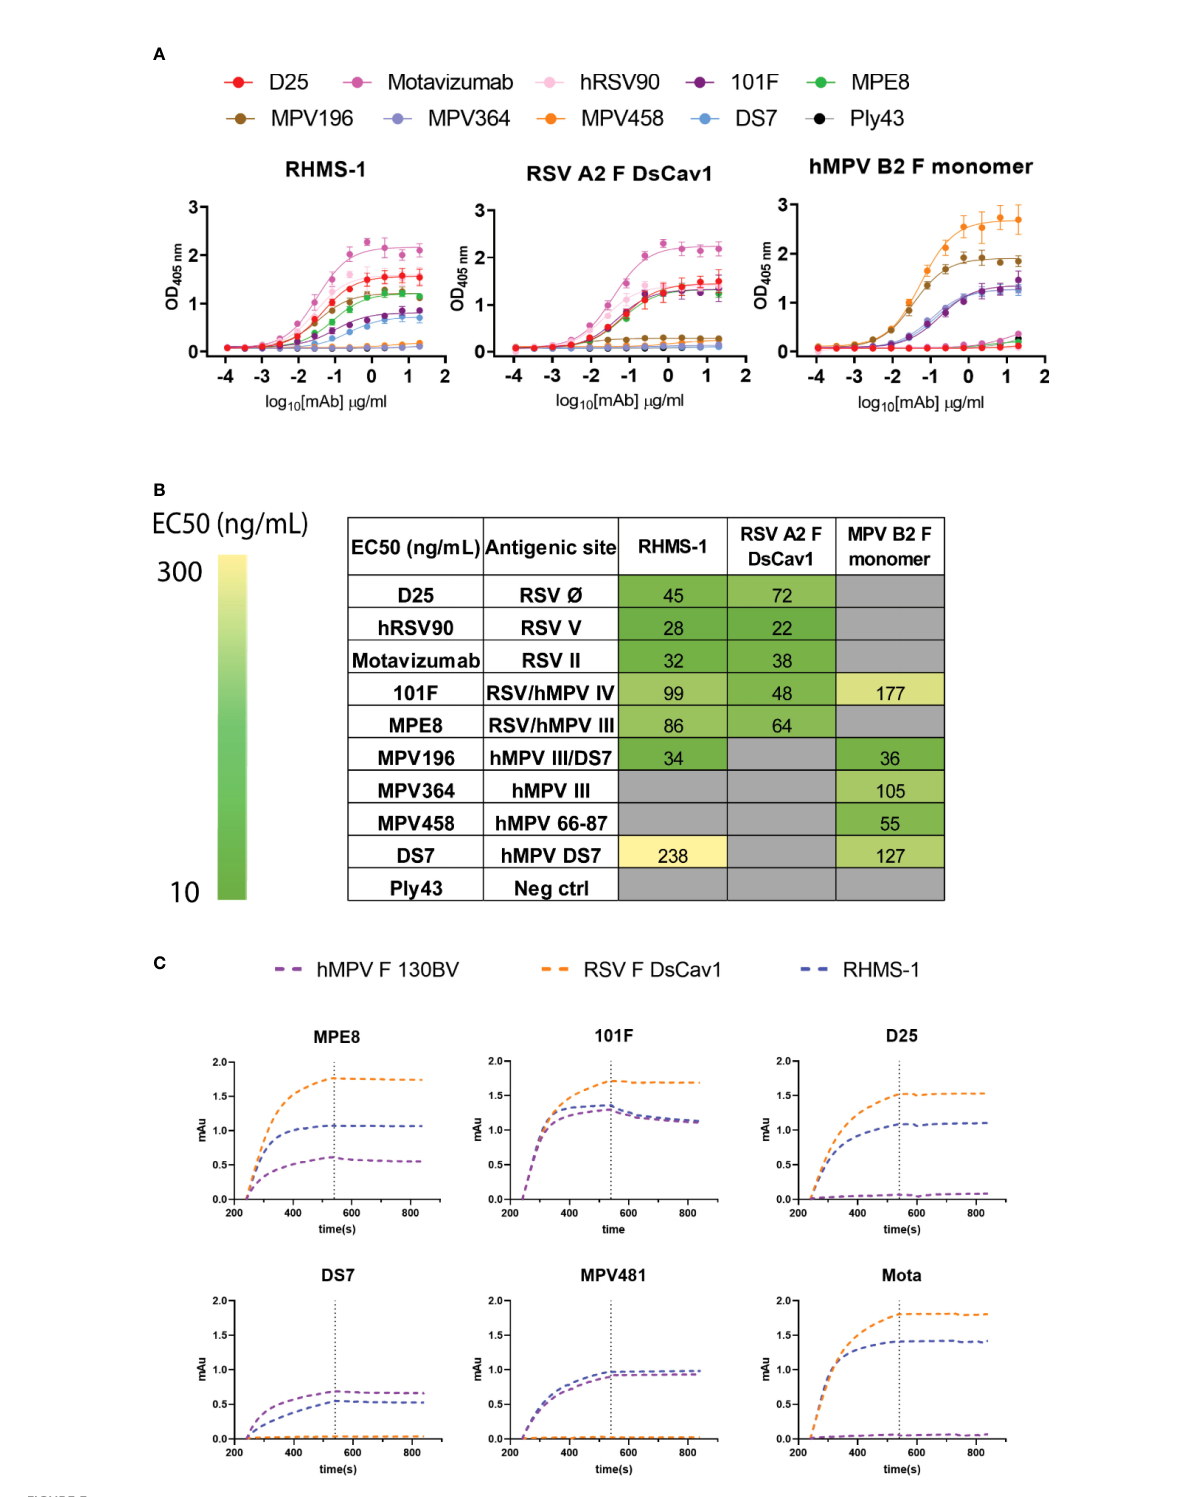
FIGURE 3 Antigenic site-speci fi c mAbs binding to F proteins. (A) ELISA binding curves of mAbs targeting different RSV/hMPV F antigenic sites against RHMS-1, RSV A2 F DsCav1, and trypsinized hMPV B2 F monomer. (B) EC 50 values of the binding curves in (A) . The binding curves and the EC 50 values were generated by GraphPad Prism. (C) BLI binding kinetics of RHMS-1, RSV A2 F DsCav1, and hMPV F 130BV with reference